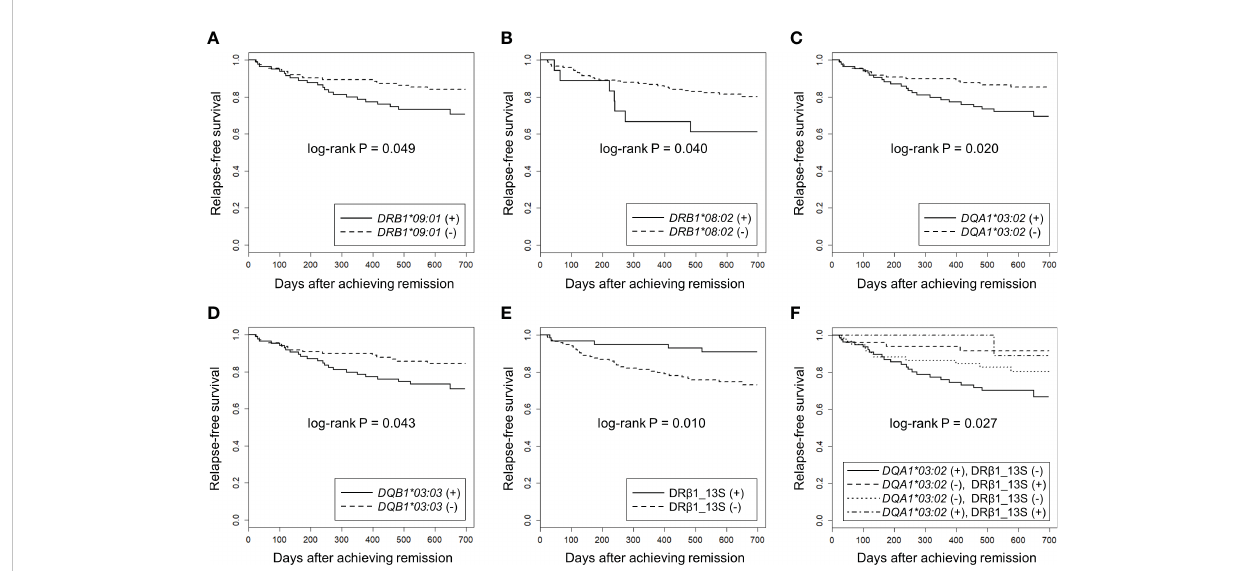
FIGURE 3 Association of HLA alleles and DR b 1 position 13 serine with relapse-free survival in MPO-ANCA single positive AAV patients using Kaplan-Meier method. The longitudinal and horizontal axes represent the probability of relapse-free survival and days after achievement of remission, respectively. Uncorrected P values calculated by log-rank test are shown. Q values corrected for multiple comparisons for each locus are shown in the text, Table 4 and Table 5. Relapse-free survival was compared between MPO-ANCA single-positive AAV patients carrying and not carrying (A) HLA - DRB1*09:01 , (B) HLA - DRB1*08:02 , (C) HLA-DQA1*03:02 , (D) HLA-DQB1*03:03 and (E) HLA-DR b 1 position 13 serine (HLA-DR b 1_13S). (F) the patients were divided into four groups according to the carriage of HLA-DQA1*03:02 and HLA-DR b 1_13S. Relapse-free survival was compared among DQA1*03:02 (+) and DR b 1_13S (-) (n=79), DQA1*03:02 (-) and DR b 1_13S (+) (n=49), DQA1*03:02 (-) and DR b 1_13S (-) (n=61) and DQA1*03:02 (+) and DR b 1_13S (+) (n=9)